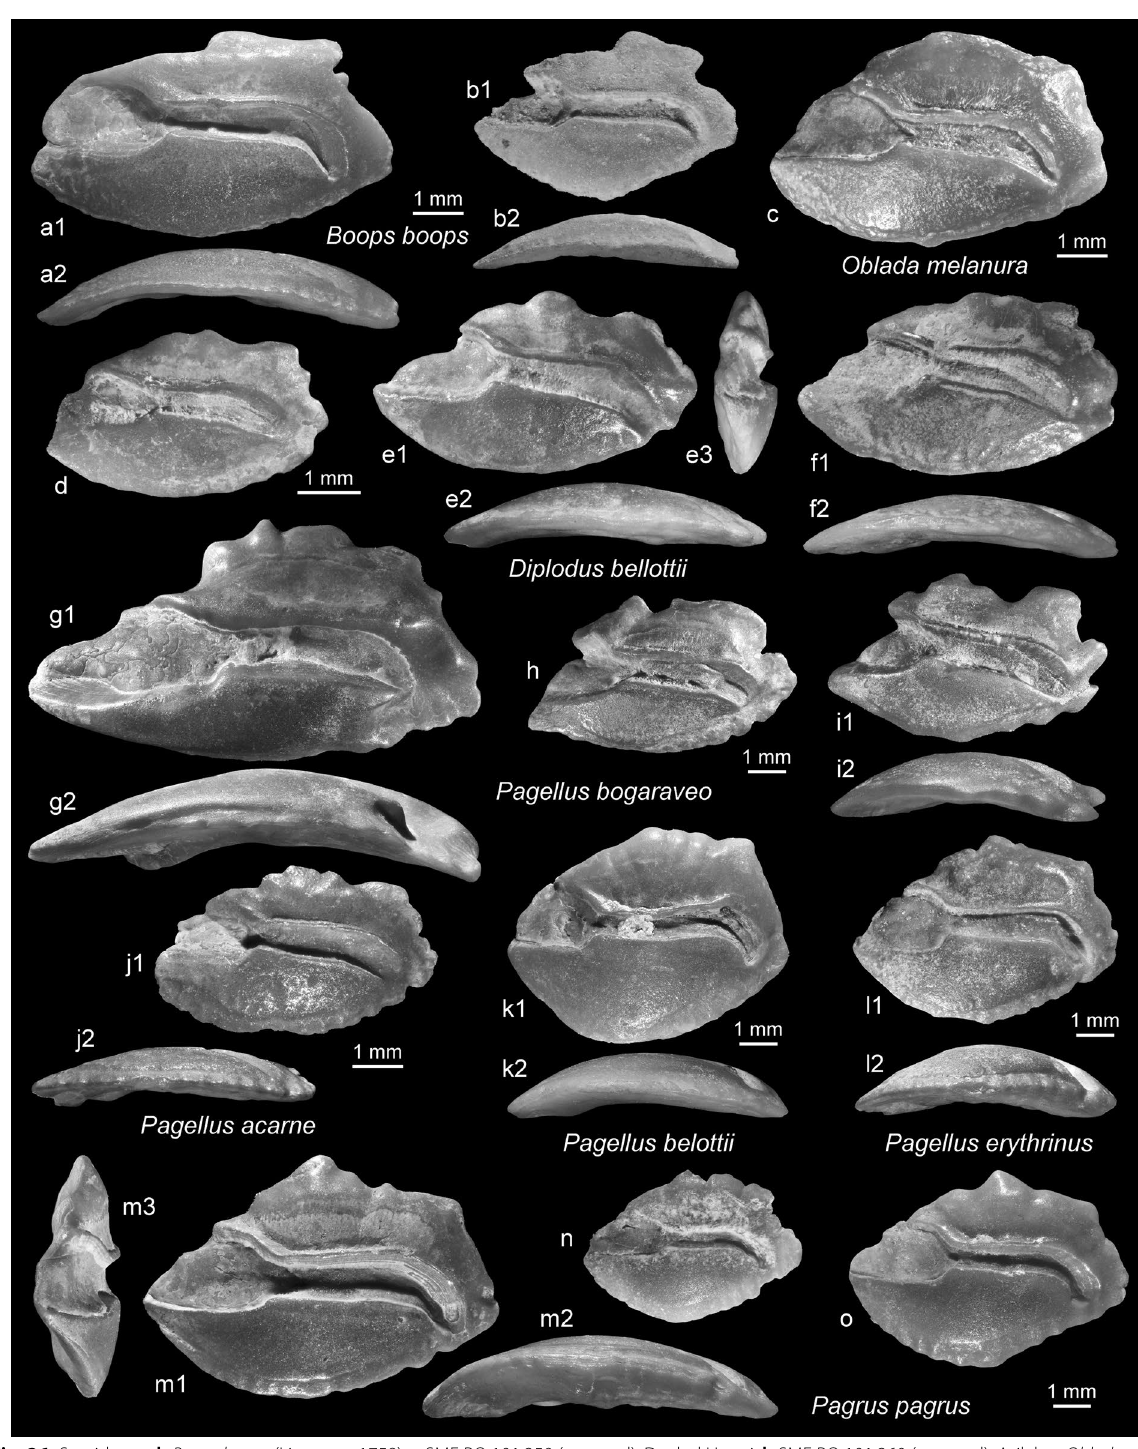
Fig. 26 Sparidae. a – b Boops boops (Linnaeus, 1758), a SMF PO 101.259 (reversed), Dar bel Hamri, b SMF PO 101.260 (reversed), Asilah. c Oblada melanura (Linnaeus, 1758), SMF PO 101.262 (reversed), Dar bel Hamri. d – f Diplodus bellottii (Steindachner, 1882), SMF PO 101.261 ( e – f